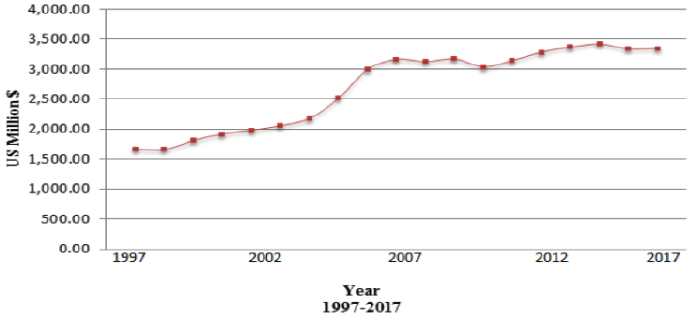
Figure 1: Migrant worker’s Remittances in Jordan (1997-2017); Source: CBJ,